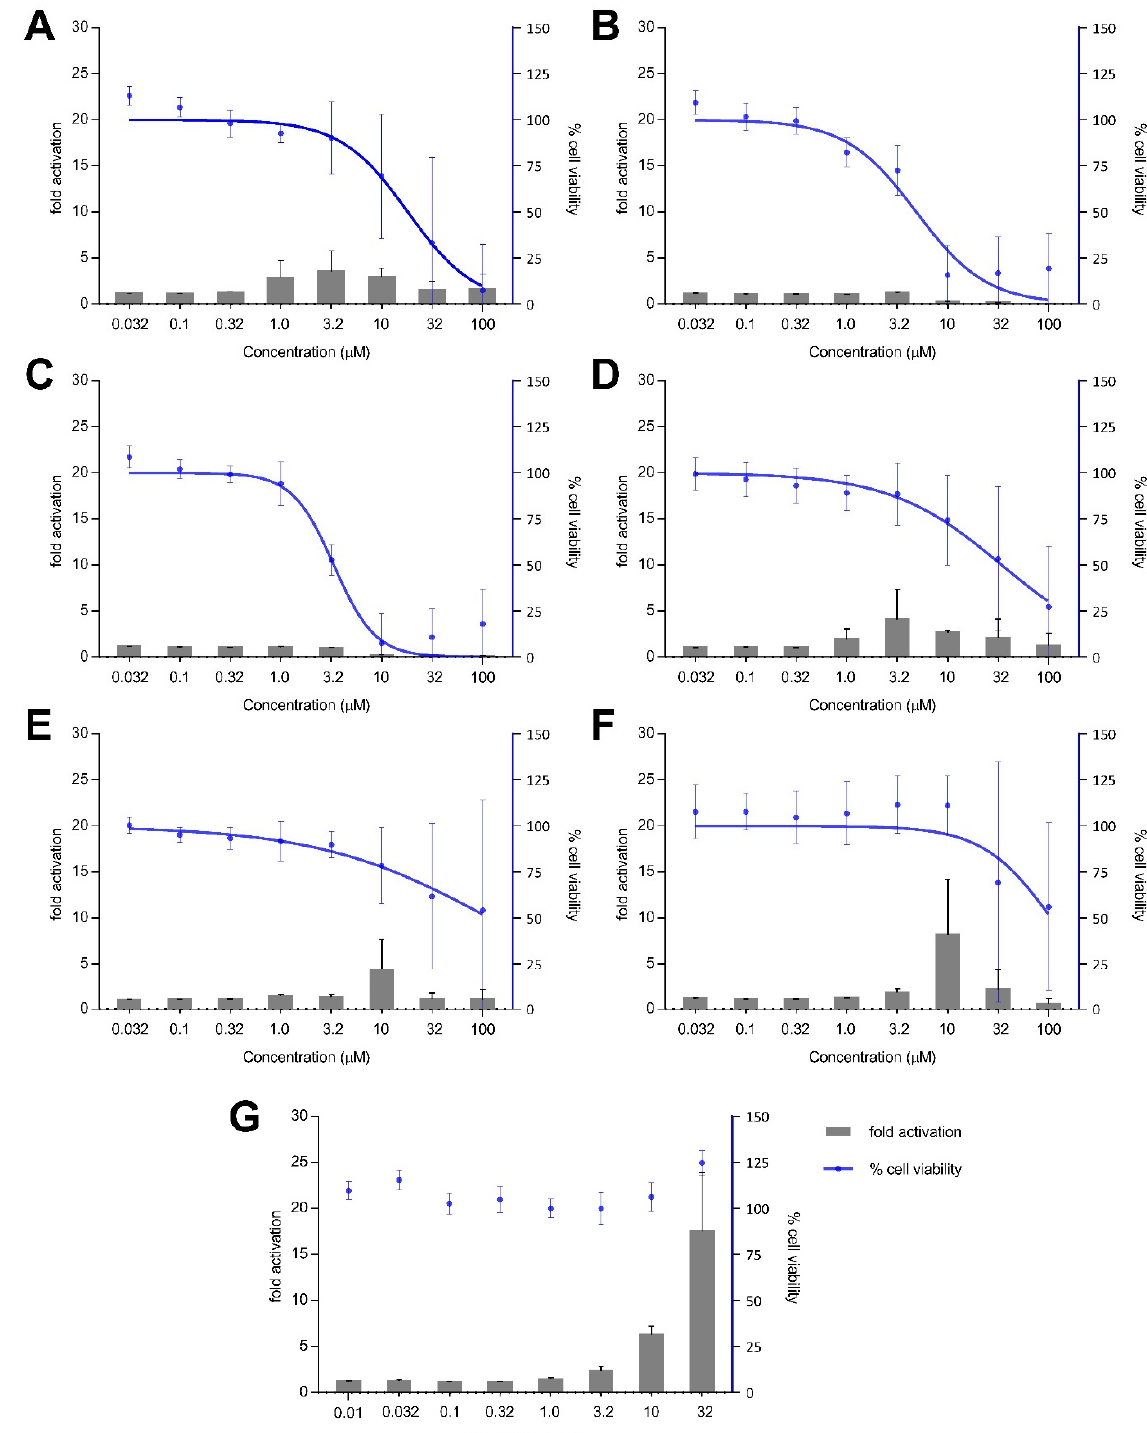
Figure 4. Nrf2-ARE fold activation (bar graph) and cell viability (line graph) effects of ( A ) xestoquinone ( 1 ), ( B ) adociaquinone B ( 2 ), ( C ) adociaquinone A ( 3 ), ( D ) 14-hydroxymethylxestoquinone ( 4 ), ( E ) 15-hydroxymethylxestoquinone ( 5 ), ( F ) 2:1 14-methoxyxestoquinone and 15-methoxyxestoquinone ( 6 ), and ( G ) t BHQ on Nrf2-luciferase reporter MCF7 stable cells after 12 h incubation. A modest increase in Nrf2 activation was observed with 1 , 4, and 6 at 12 h posttreatment. Fold activation is presented as mean + SD, while the % cell viability is presented as mean ± SD from two independent experiments with three replicates each.